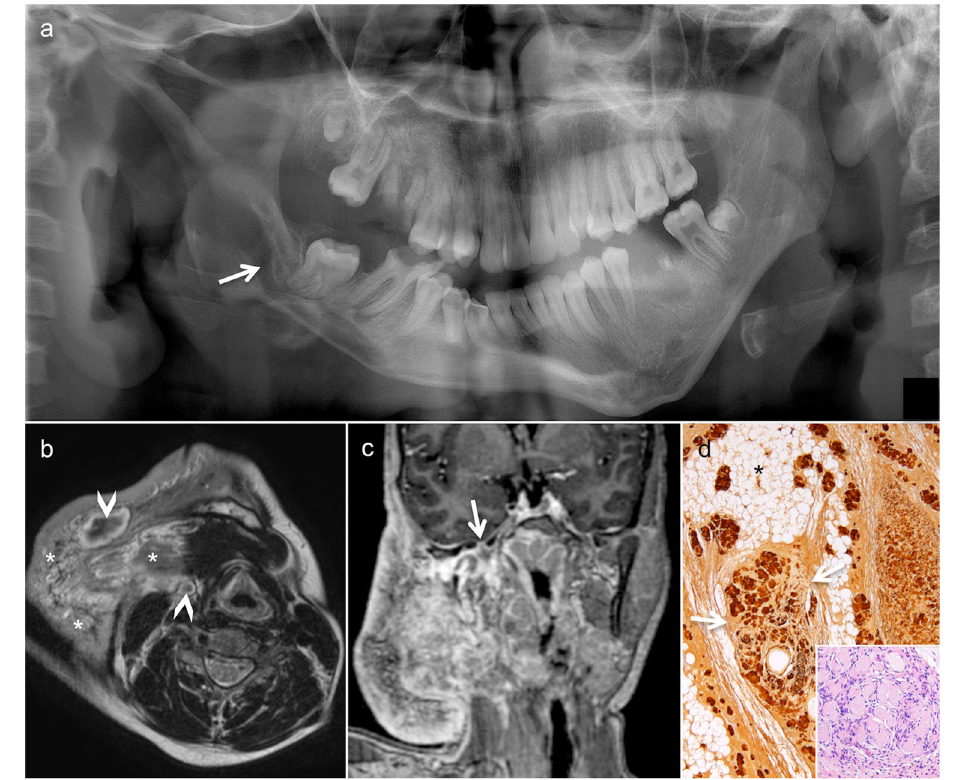
c Gadolinium-enhanced coronal fat-saturated T1 shows large, infiltrative and multilobulated PNF involving the entire hemiface with perineural spread and extension to the right foramen ovale ( arrow ). d Immunohistochemistry (original magnification, ×40; S100 protein) ob- tained from surgical specimen highlights plexiform nerve bundles ( arrows ) dissecting the adipose tissue of the hypodermis ( asterisk ). Numerous confluent Wagner-Meissner bodies are seen ( inset , original magnification, ×200; H&E